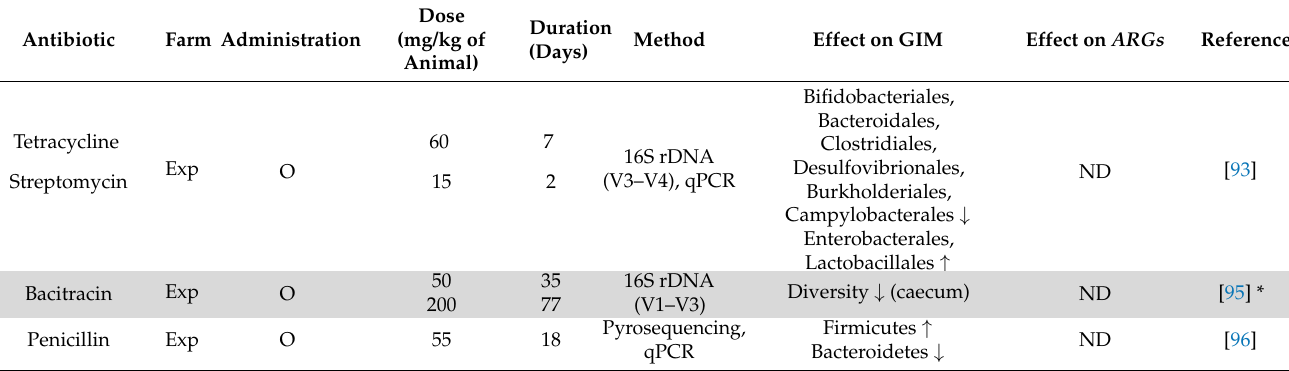
Table 3. Summary of studies investigating impact of antibiotics on chickens’ intestinal microbiota and relative antibiotic resistance